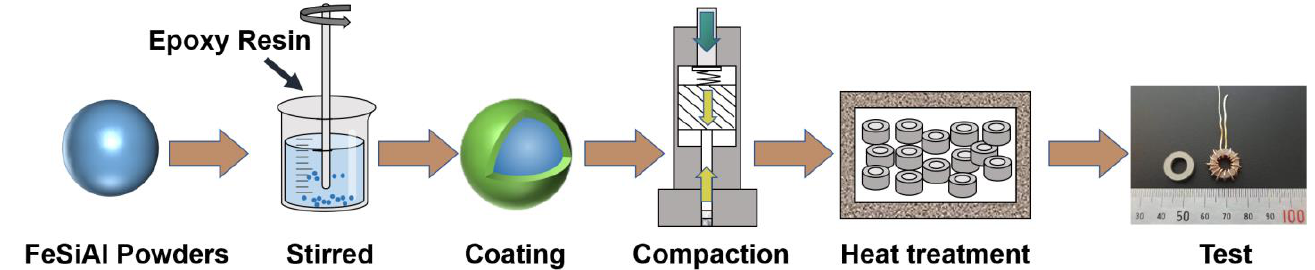
Figure 1. Schematic diagram of fabrication process for FeSiAl SMPCs.